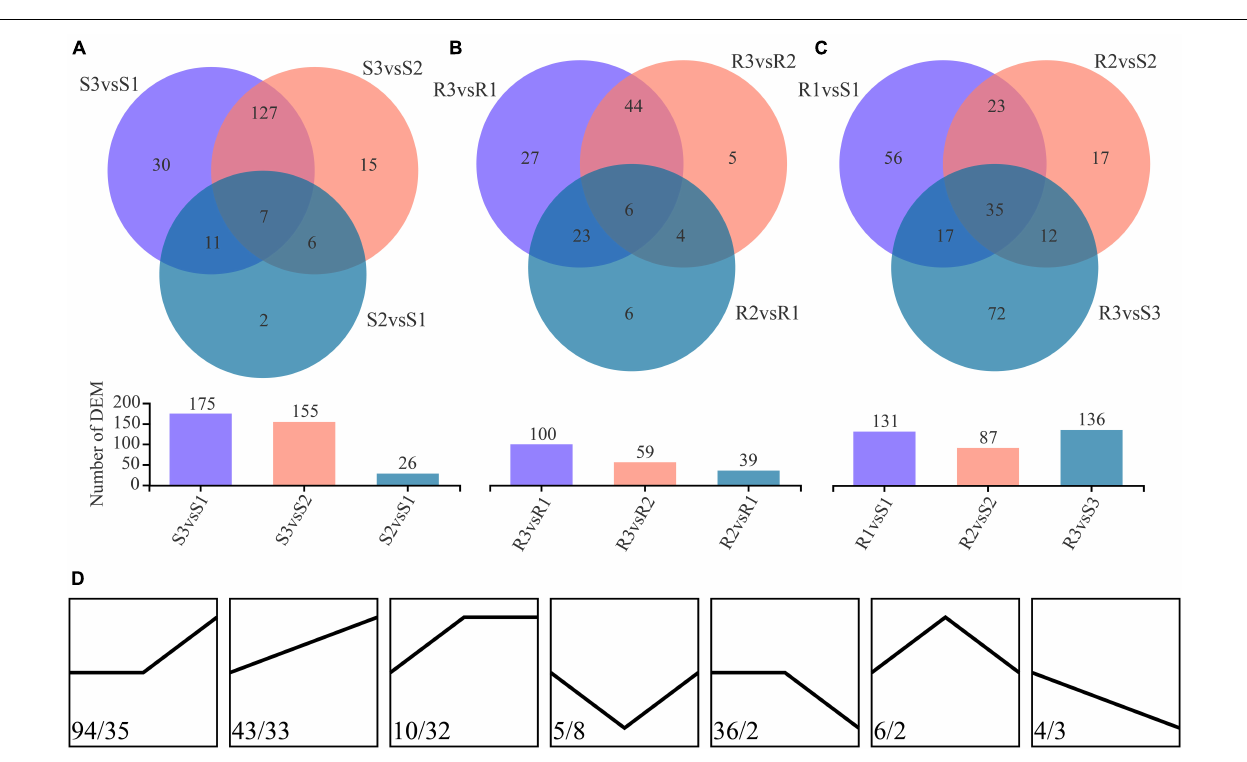
FIGURE 3 | Differentially expressed metabolites (DEMs) identified during the infection process. (A) DEMs identified during the compatible interactions. (B) DEMs identified during the incompatible interactions. (C) DEMs identified between the compatible and incompatible interactions. (D) Change trend of the DEMs in the compatible (the values before the slash) and the incompatible (the values after the slash)